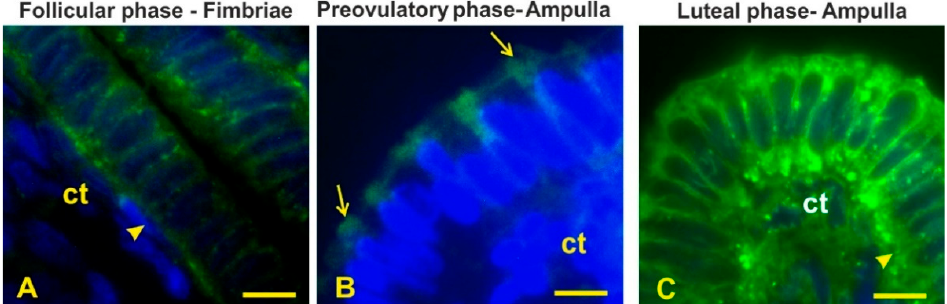
Figure 10. Mannosylated glycan localization as identified by Con A staining in the baboon Papio